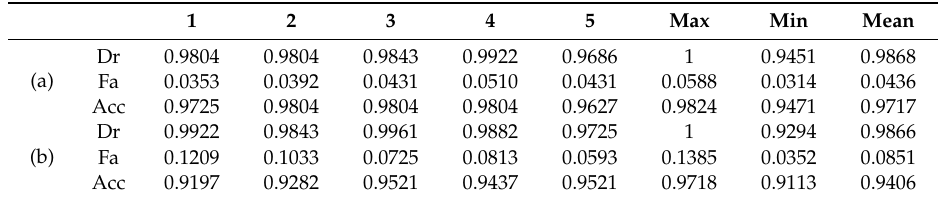
Table 6. Detection and false alarm